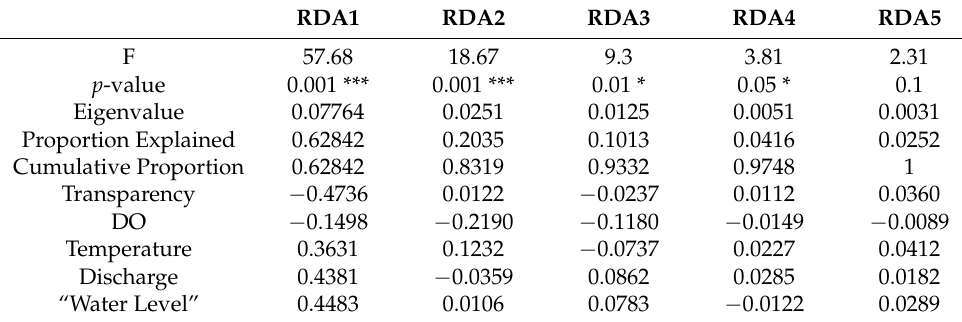
Table 4. Summary of the redundancy analysis (RDA). * = p < 0.05; *** = p <